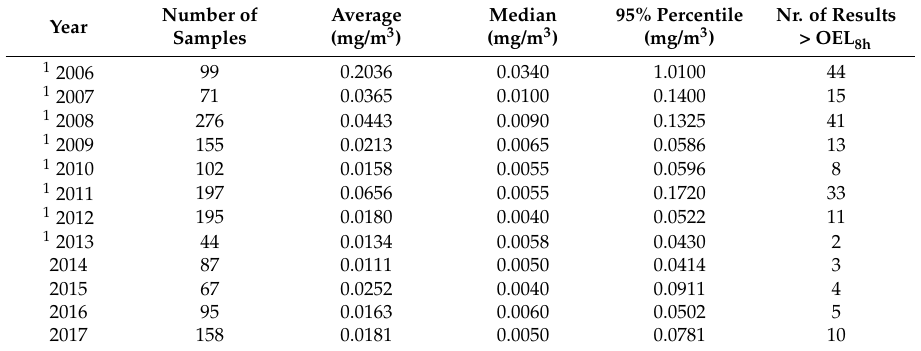
Table 1. Exposure to respirable quartz in workplace measurements during the years 2007–2017.